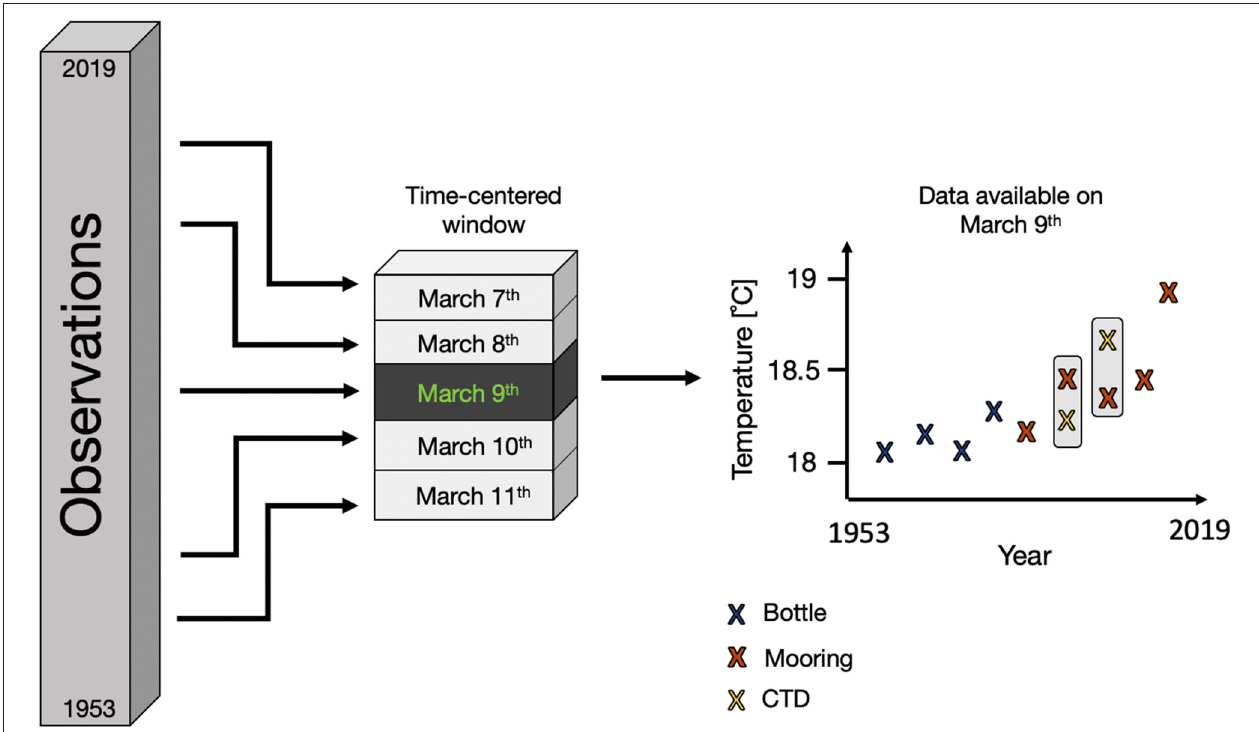
FIGURE 7 | A visual representation of the time-centered window binning process for March 9th. Data displayed in the plot on the right that would be averaged prior to calculating climatology statistics (Date-averaging) are highlighted by the gray